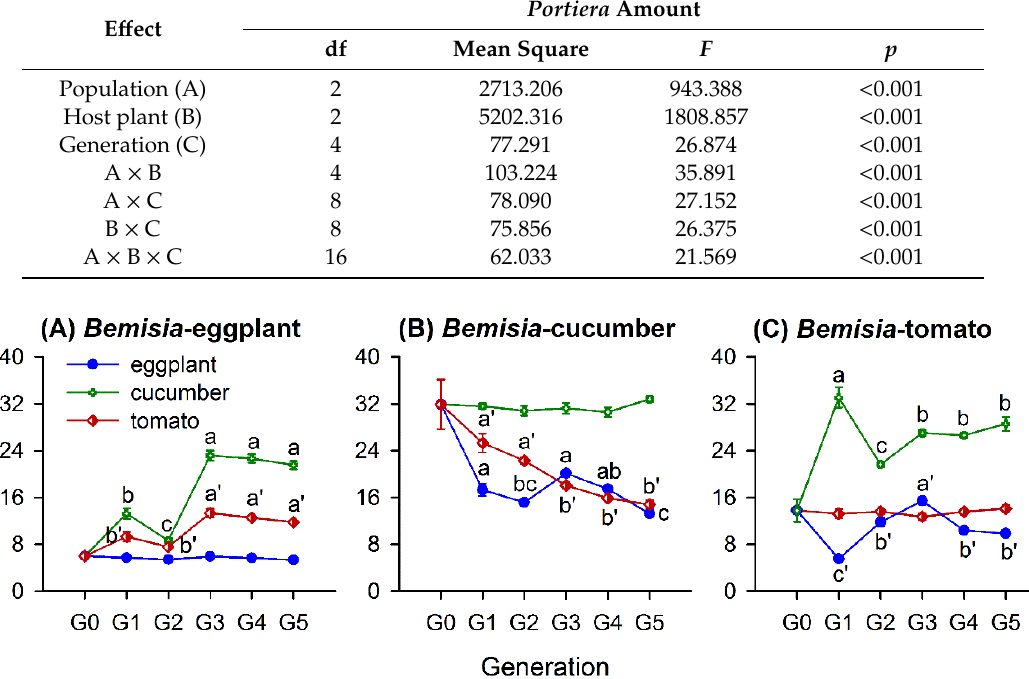
Figure 3. Relative amounts of Portiera (mean ± SE) in whitefly populations of Bemisia -eggplants ( A ), Bemisia -cucumbers ( B ), and Bemisia -tomatoes ( C ) transferred to natal and novel host-plant species for different generations, ranging from G0 to G5. The relative amount of each symbiont taxon was normalized using β-actin and calculated by the 2 -Δ C t method. Different lowercase letters and lowercase letter variants, i.e., a′, b’ and c′, around the error bars indicate significant differences among different generations after a transfer to a novel host-plant species ( p < 0.05, Tukey’s HSD test).